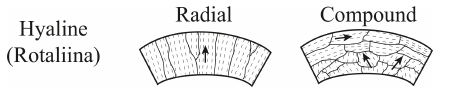
Figure 1. Wall structures of polycrystalline hyaline perforate foraminifers (modified after Armstrong and Brasier,